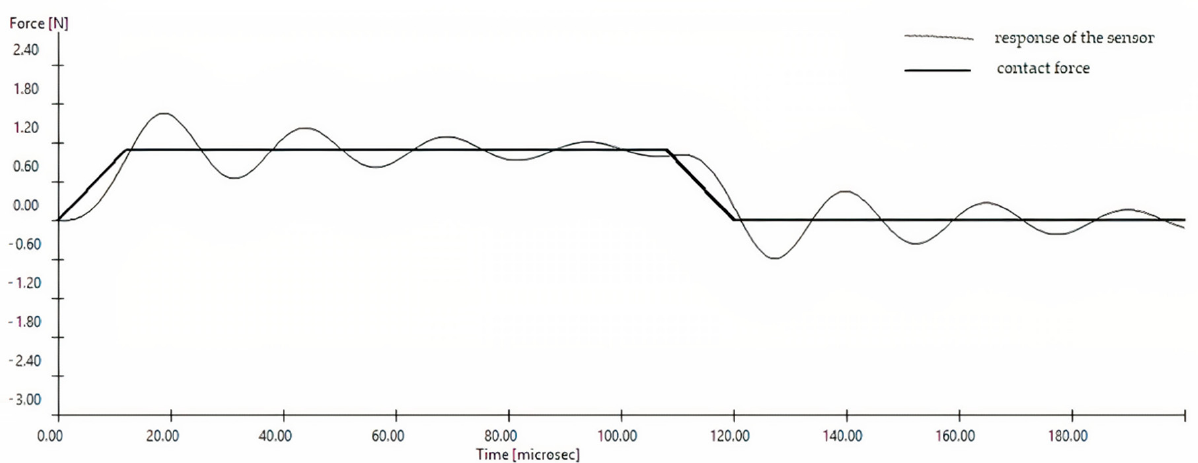
Figure 8. The course of the impact force and measurement signal from the sensor for the perfectly plastic model and large soft grains. The contact force value was k 1 = 1 × 10 4 Nm − 1 , f re z = 20 kHz.